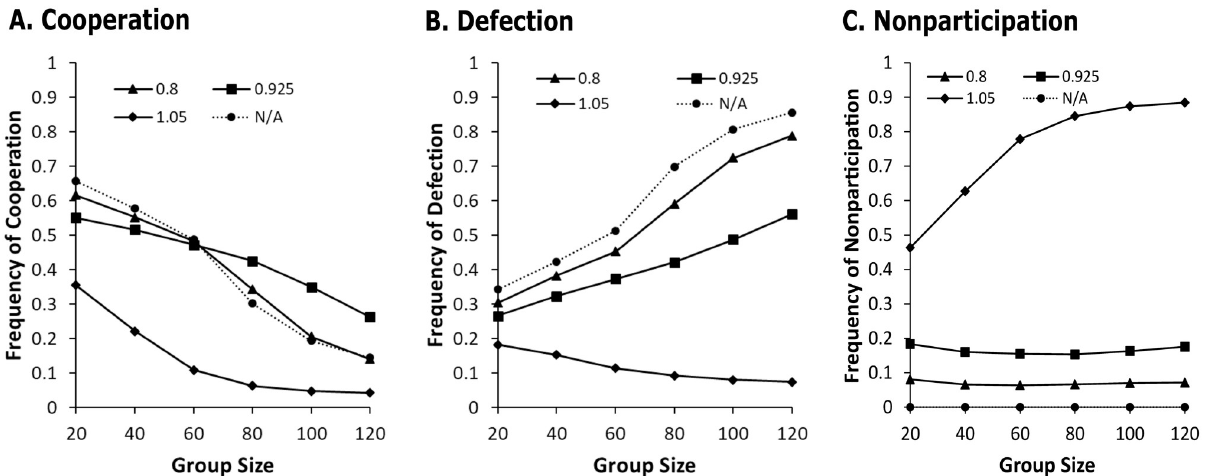
Fig 2. The long run average frequencies of participation (cooperation and defection) and nonparticipation. (A) Cooperation (including contributors and punishers); (B) Defection; and (C) Nonparticipation. The dotted lines indicate the long run results of the compulsory participation scenario, and the solid lines the long run results of the voluntary participation scenarios. Three types of markers (triangle, square, and diamond) of the solid lines represent the low level of nonparticipants’ payoff (0.8), the moderate (0.925), and the high (1.05), respectively. N/A signifies compulsory participation. The data used in this figure are provided in S1